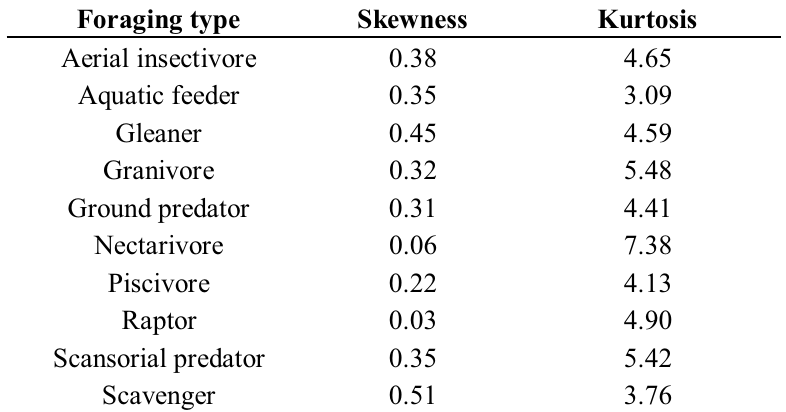
Table 2. Relationship of foraging type on kurtosis. A Kruskal-Wallis rank test indicated significant differences among feeding types.